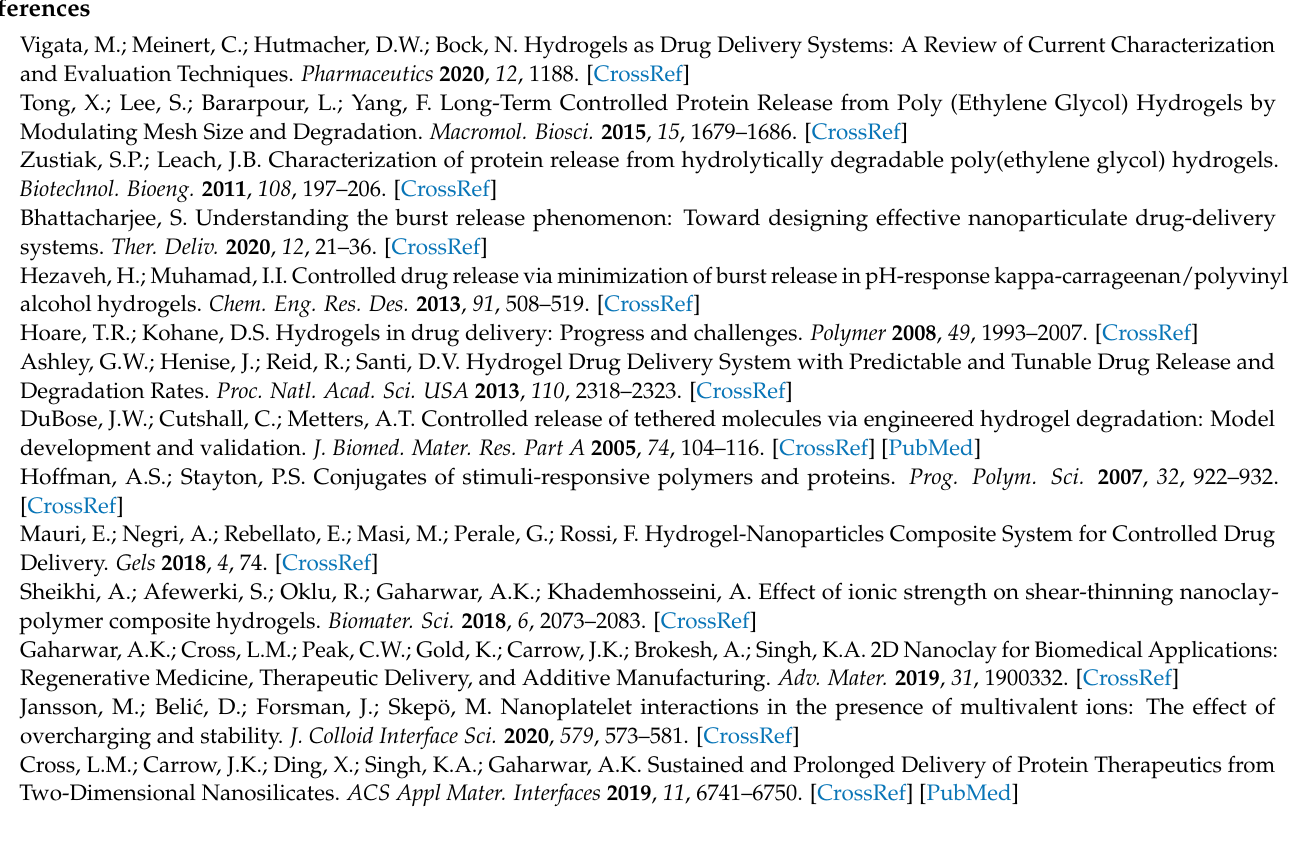
Figure S3: Rheology of Hydrogel Precursor Solutions, Figure S4: Swelling Kinetics of PEG Hydrogels, Figure S5: Shear-thinning Behavior of NS is Retained, Figure S6: Porosity of Hydrogels Measured with SEM, Figure S7: Influence of NS/AO Incubation Time with 10 mg/mL NS, Figure S8: Release of Alexa 647, Figure S9: Release of Atto Rho